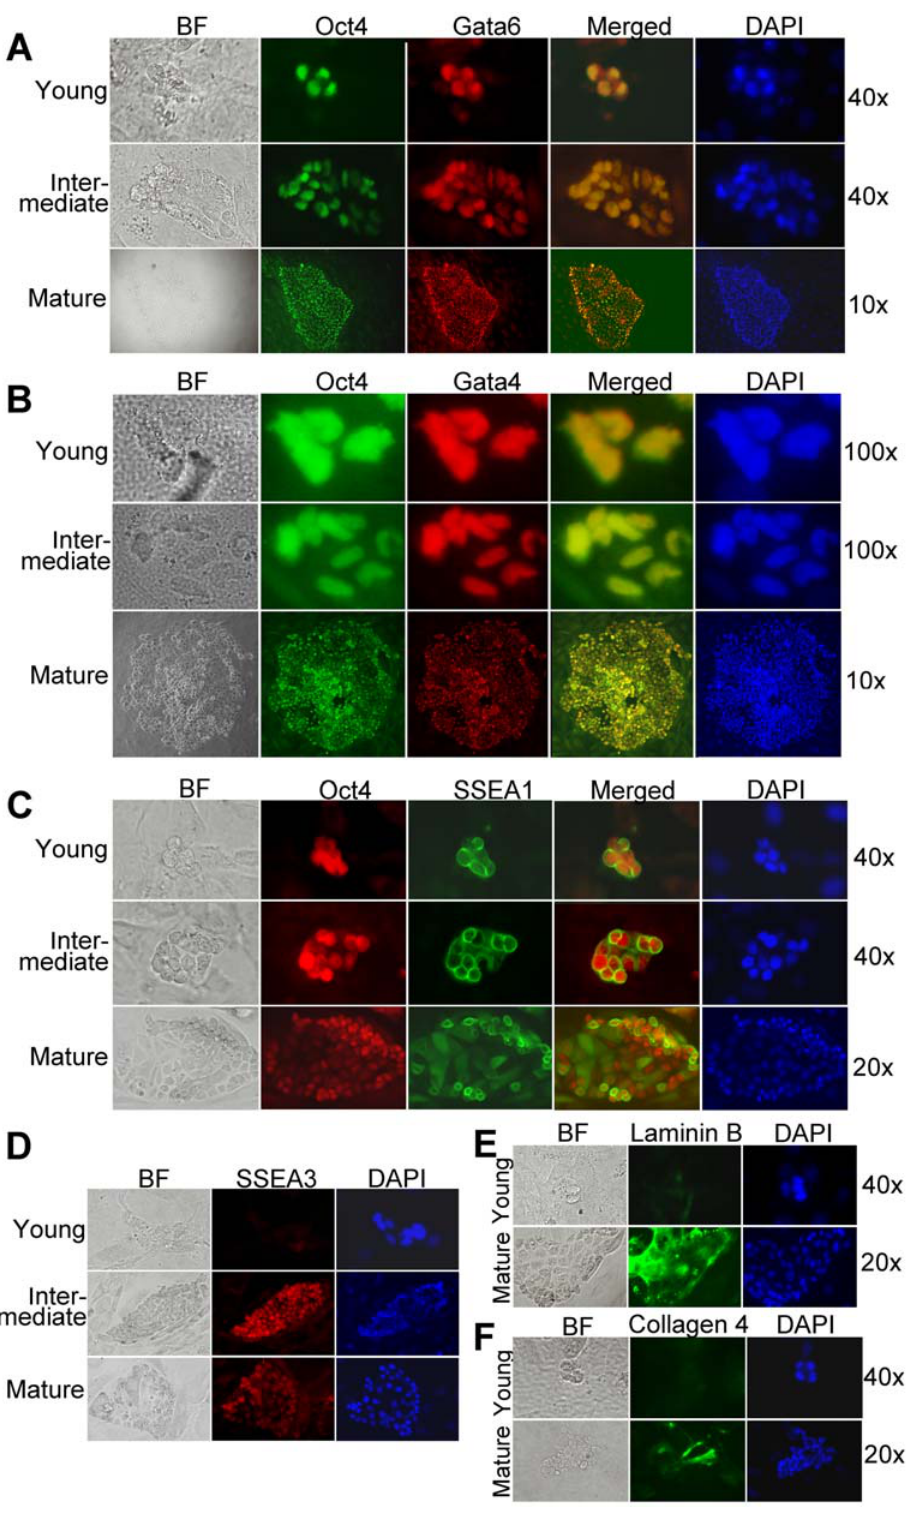
Figure 4. Lineage marker analysis during the evolution of colonies growing after low-density plating of a rat XEN-P cell line (RX1). ( A ) Double staining for Oct4 (green) and Gata6 (red); ( B ) Double staining for Oct4 (green) and Gata4 (red); ( C ) Double staining for Oct4 (red) and SSEA1 (green); ( D ) Staining for SSEA3; ( E ) Staining for Laminin B; ( F ) Staining for Collagen 4. BF, bright field. RX1 cells were plated at 25–50 cells/cm 2 , and at different time points, the resulting colonies were stained with the indicated antibodies and counterstained with DAPI. Controls omitting primary antibodies were negative and are not shown. The speed of colony evolution varied somewhat between experiments, resulting in ‘‘Young’’ colonies at days 2–3, ‘‘Intermediate’’ colonies at days 3–5, and ‘‘Mature’’ colonies at days 5–7 (day 0=day of plating).